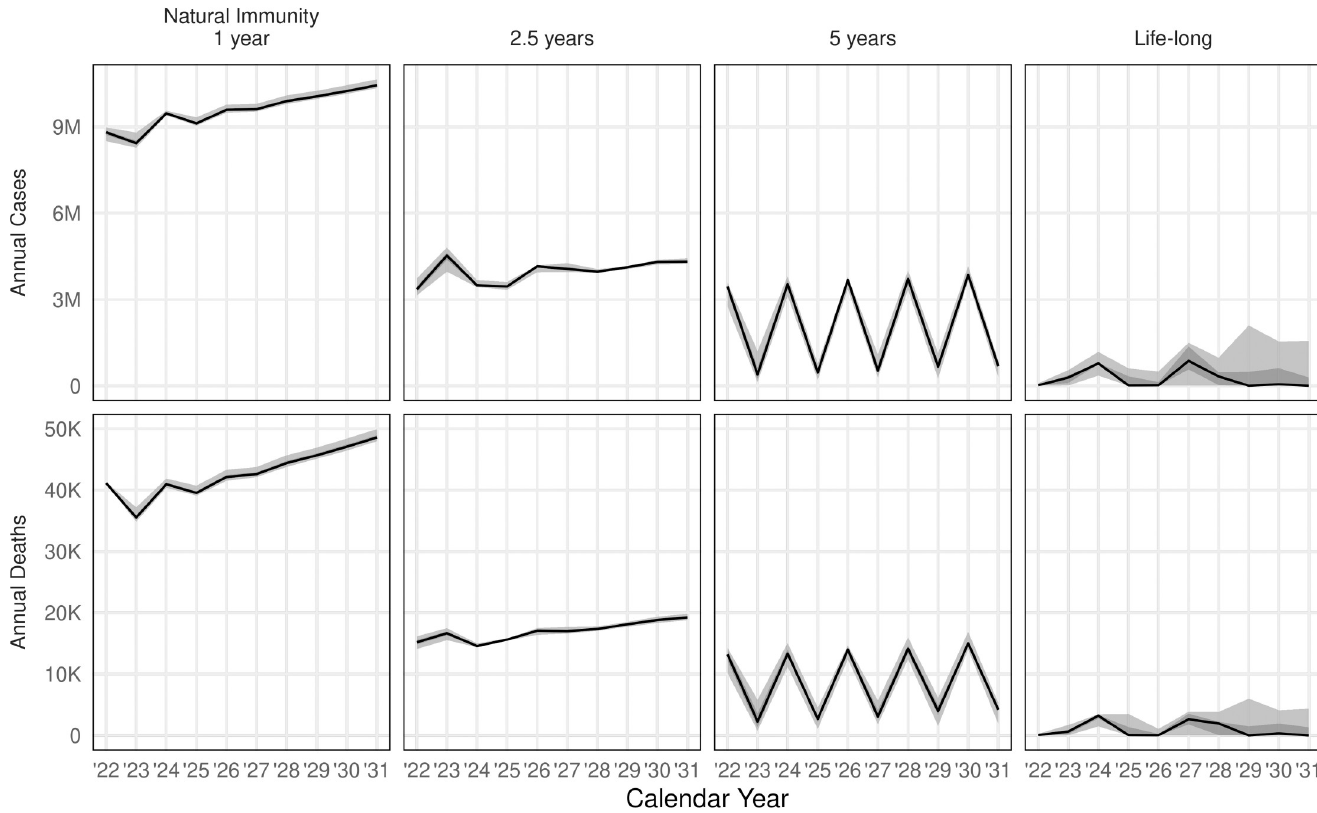
Fig 2. Long-term baseline projections without vaccination for different assumptions about the duration of natural immunity. Black line shows median simulation, and grey windows mark 50 and 95% simulation intervals.